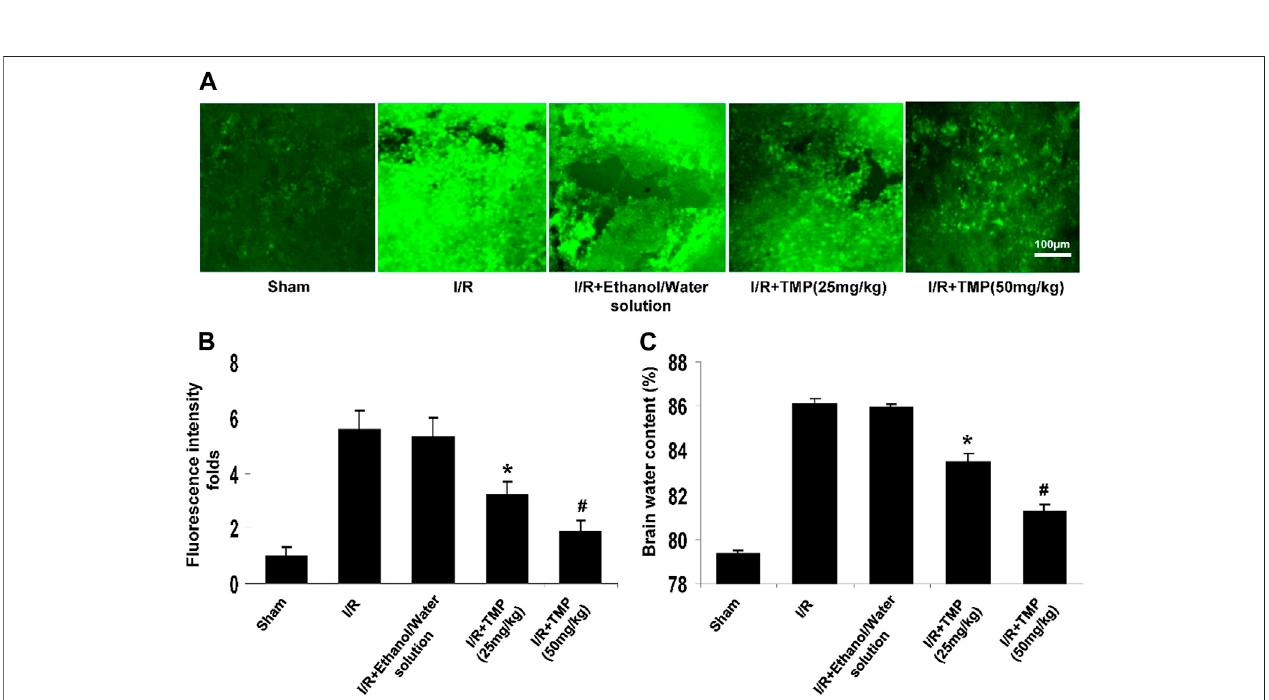
FIGURE 2 | TMP improves BBB permeability and brain edema in ischemic brain injury. The C57/BL mice were treated with TMP 25 mg/kg or 50 mg/kg or vehicle administered intraperitoneally 12 h before and after 2 h of MCAO, followed by 24 h reperfusion. (A) Representative photomicrographs of brain sections showing extravasationoftheFITC-dextranidenti fi edby fl uorescencestaining( green )inperi-infarctcorticalareas. (B) The fl uorescenceintensityofFITC-dextranwasquanti fi edby a fl uorescence microscope (Leica TCS SP5). * p < 0.05, # p < 0.01 versus the sham-operated controls. (C) TMP attenuated cerebral ischemia/reperfusion-induced brain edema in a dose-dependent manner. * p < 0.05, # p < 0.01 versus the I/R group. n (cid:1) 6 per group.